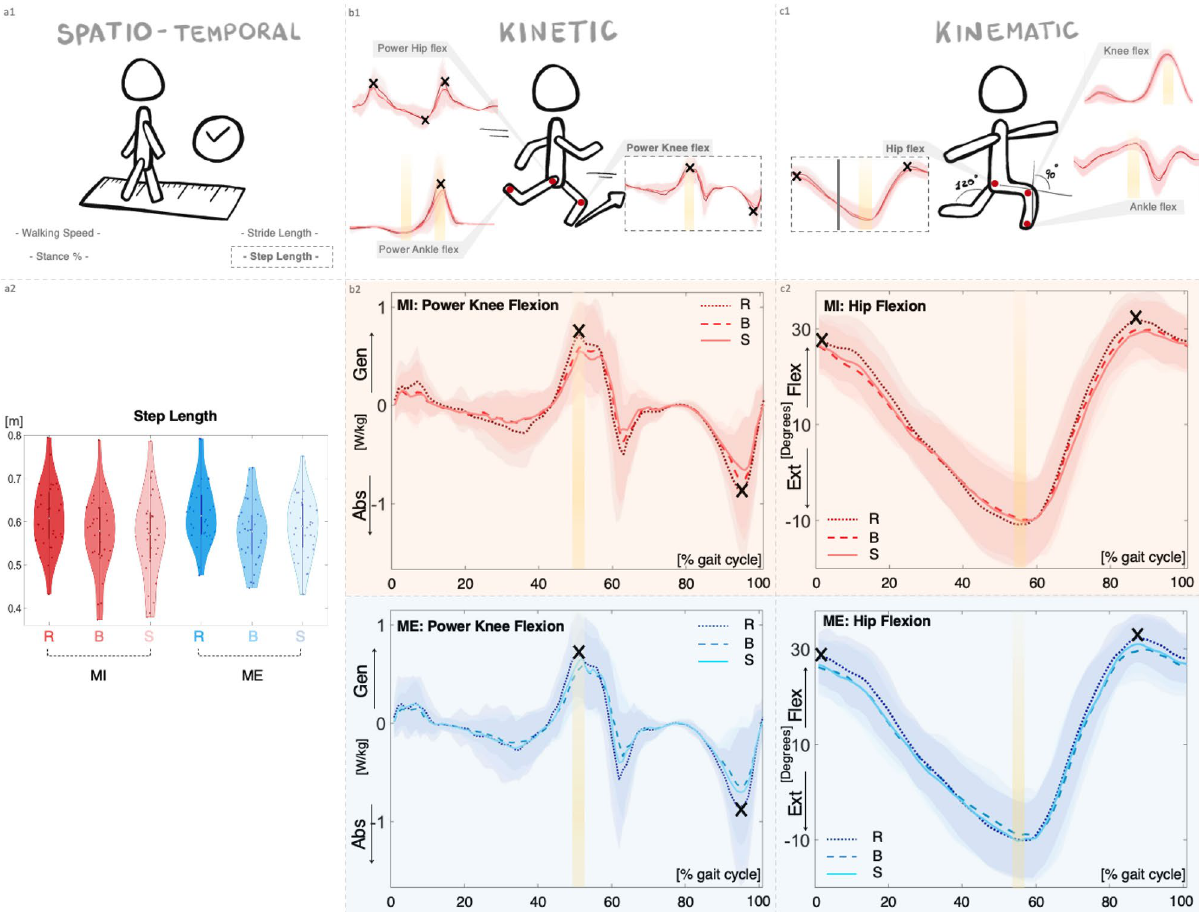
Figure 2. Graphical representation of parameters for which BR as well as SR are statistically significant for both MI and ME condition (corresponding to the parameters on white background in Table 1). [Top panel] [1]: Spatio-temporal parameters (left, [a1]), kinetics curves (middle, [b1]) and kinematics curves (right, [c1]) are reported. The “X” symbols highlight statistically significant differences in the amplitude of peaks, while the yellow bars refer to the statistically significant differences in the timing of peaks. Gray bar in [c1] indicates statistical significance for the range of motion (ROM) value. Curves illustratively refer to the MI condition (accordingly, they are depicted with red nuances. See below). Please, note that the illustration depicts a specific subset of parameters satisfying the “risky-scenario-driven” approach (i.e., BR as well as SR are statistically significant both for MI and ME, corresponding to the parameters on white background in Table 1). [Bottom panel, Left part] [a2]: Illustrative spatio-temporal data. Violin plot of the step length parameter for the MI (red) and ME (blue) condition; shade of red/blue are used for the safe (light), baseline (medium), and the risky (dark) scenarios. [Bottom panel, Middle part and Right part]: Illustrative kinetic data [b2]. Curves representing the power of the knee during flexo-extension in the MI condition (up), and in the ME condition (down). Illustrative kinematic data [c2]. Curves representing the hip flexo-extension in MI condition (up), and in the ME condition (down). For both kinetic and kinematic illustrative data, each curve represents the median curve considering 32 participants. Distinct “colors + type of line” combinations refer to the distinct conditions and scenarios (for MI: dark red + dots = risky; medium red + dashed line = baseline; light red + line = safe) (for ME: dark blue + dots = risky; medium blue + dashed line = baseline; light blue + line = safe). The areas in the background are the interquartile ranges. The “X” symbols highlight statistically significant differences in the amplitude of peaks, while the yellow bars refer to the statistically significant differences in the timing of peaks. MI: Motor Interference condition, ME: Motor Expectation condition, B: Baseline, R: Risky scenario, S: Safe